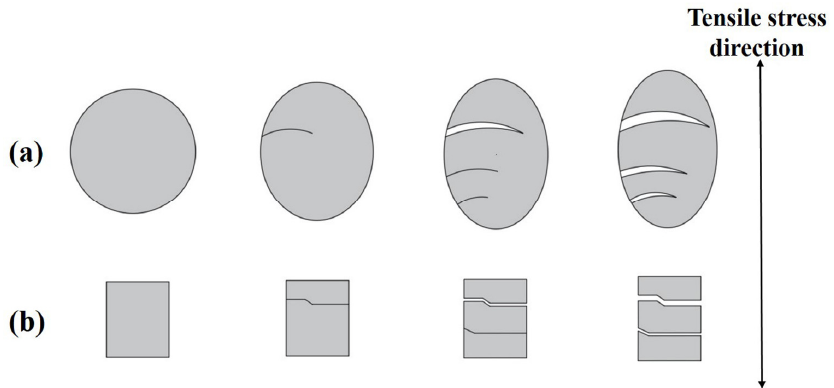
Figure 6. Schematic of the growth behavior of the microcracks when subjected to tensile stress. ( a ) CaO·(Al 2 O 3 ) x inclusion and ( b ) TiN inclusion.